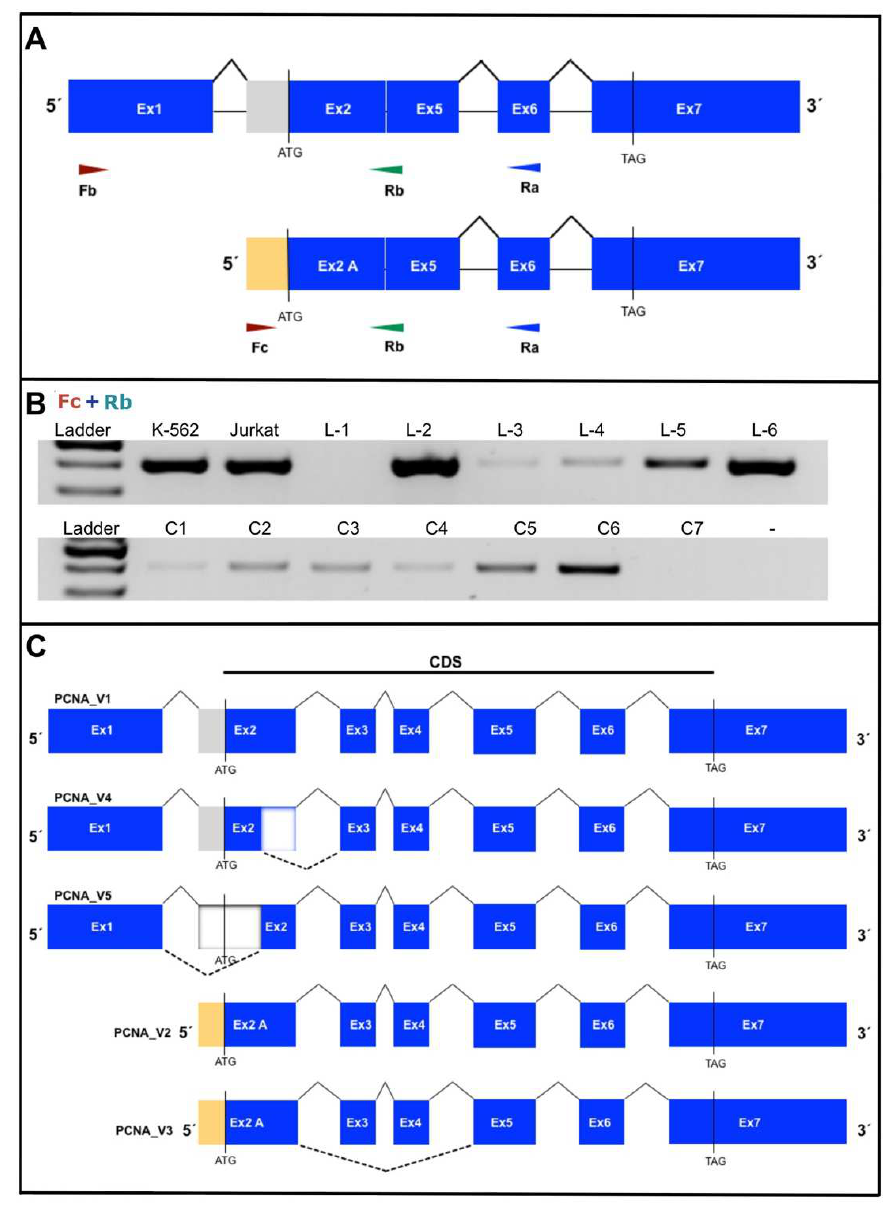
Figure 4. Amplification of the novel PCNA transcript variant 3 (PCNA_V3). ( A ) The figure shows the specific design of PCR primers to amplify PCNA_V3, which is located in the boundary site between exons 2 and 5. ( B ) Specific amplification of PCNA_V3 shows the PCR product at ~400 bp